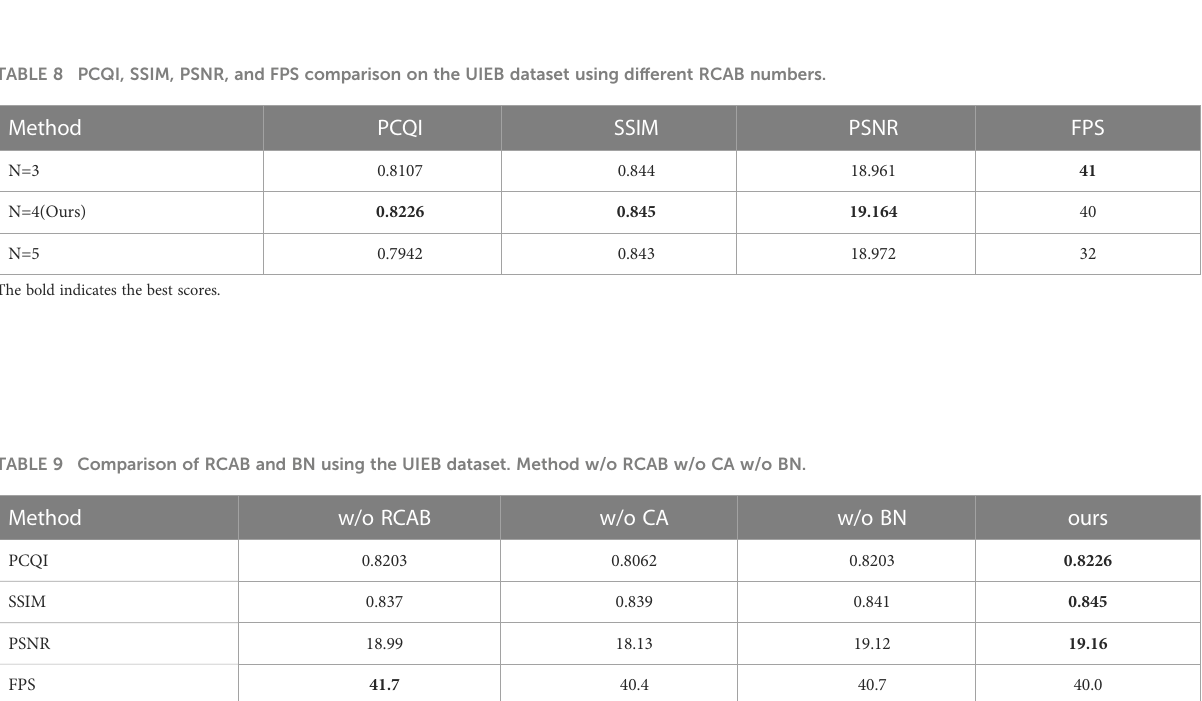
The bold indicates the best scores.